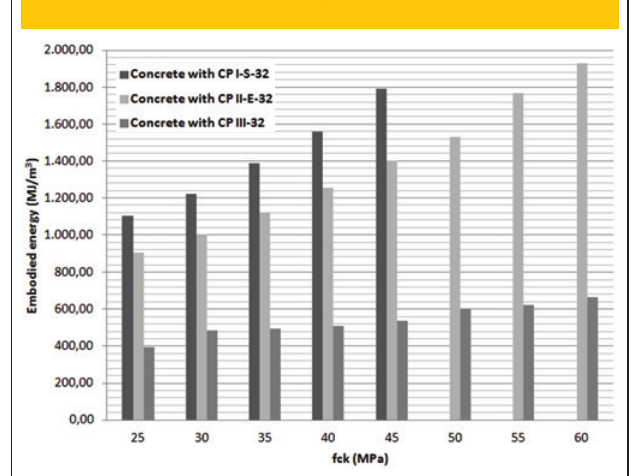
3 Figure 7 – Blue water footprint calculated for 1 m